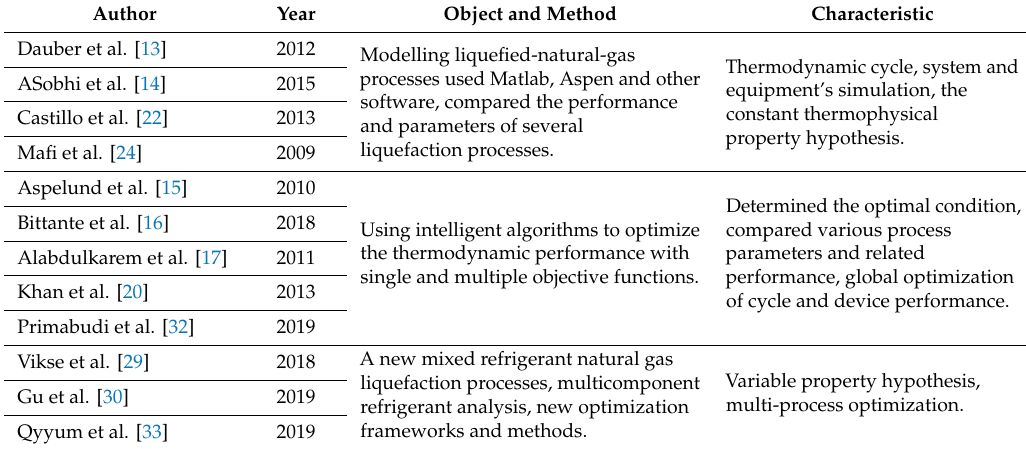
Table 1. Literature review and